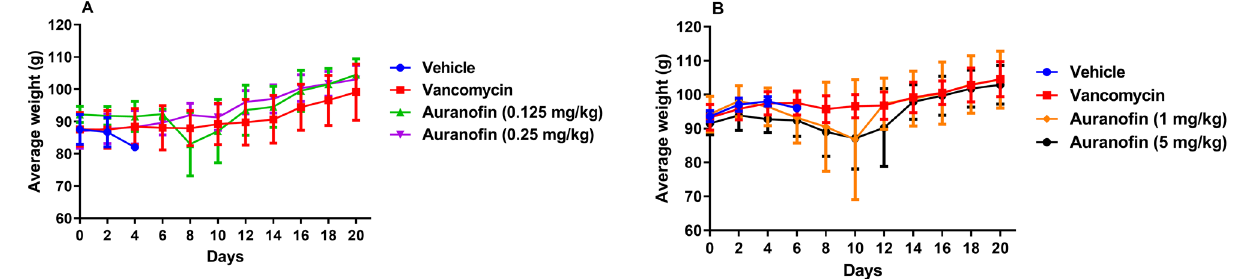
Figure 4. Average weight of all surviving hamsters in the CDI recurrence experiments: ( A ) low doses of auranofin (0.125 mg/kg and 0.25 mg/kg) and ( B ) high doses of auranofin (1 mg/kg and 5 mg/kg). Infected hamsters were treated with auranofin, vancomycin (20 mg/kg), or the vehicle for 5 days and treatments were discontinued thereafter. Hamsters were weighed every other day until the end of each experiment. The data are presented as average weight (g) (mean ± standard deviation) for each group.